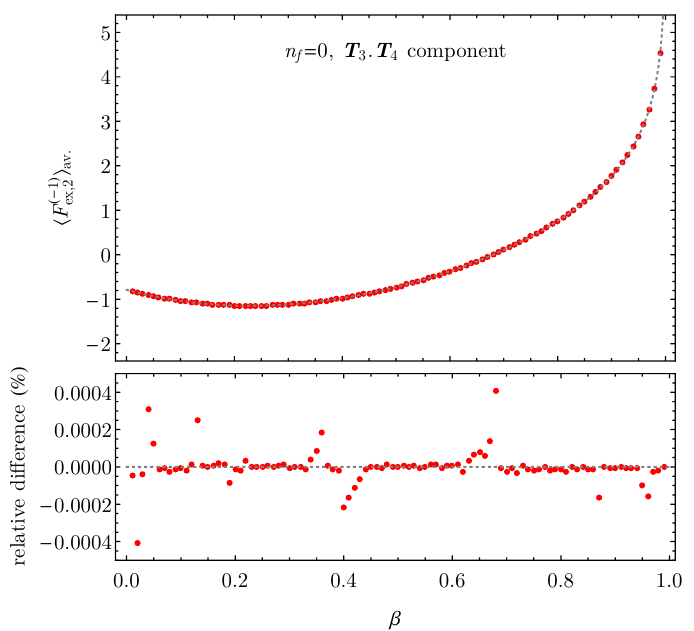
Figure 1 . Numerical results for the coefficient of the 1 /(cid:15) pole of the contribution proportional to T 3 · T 4 in F ex , 2 (red points), compared to the expected analytical result (gray curve) from eq. (2.38). The lower plot shows the relative difference (in percentage) between the